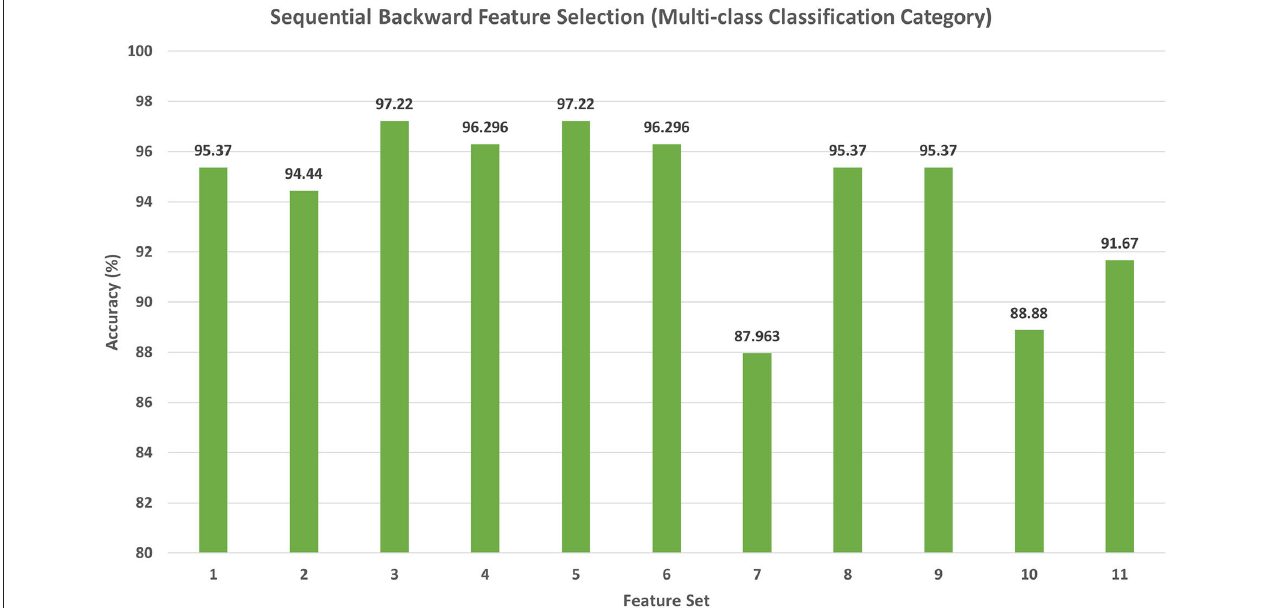
FIGURE 5 | The classification accuracy (%) attained for the different feature sets generated using backward strategy. Feature set 1: DenseNet-201 Shuffle